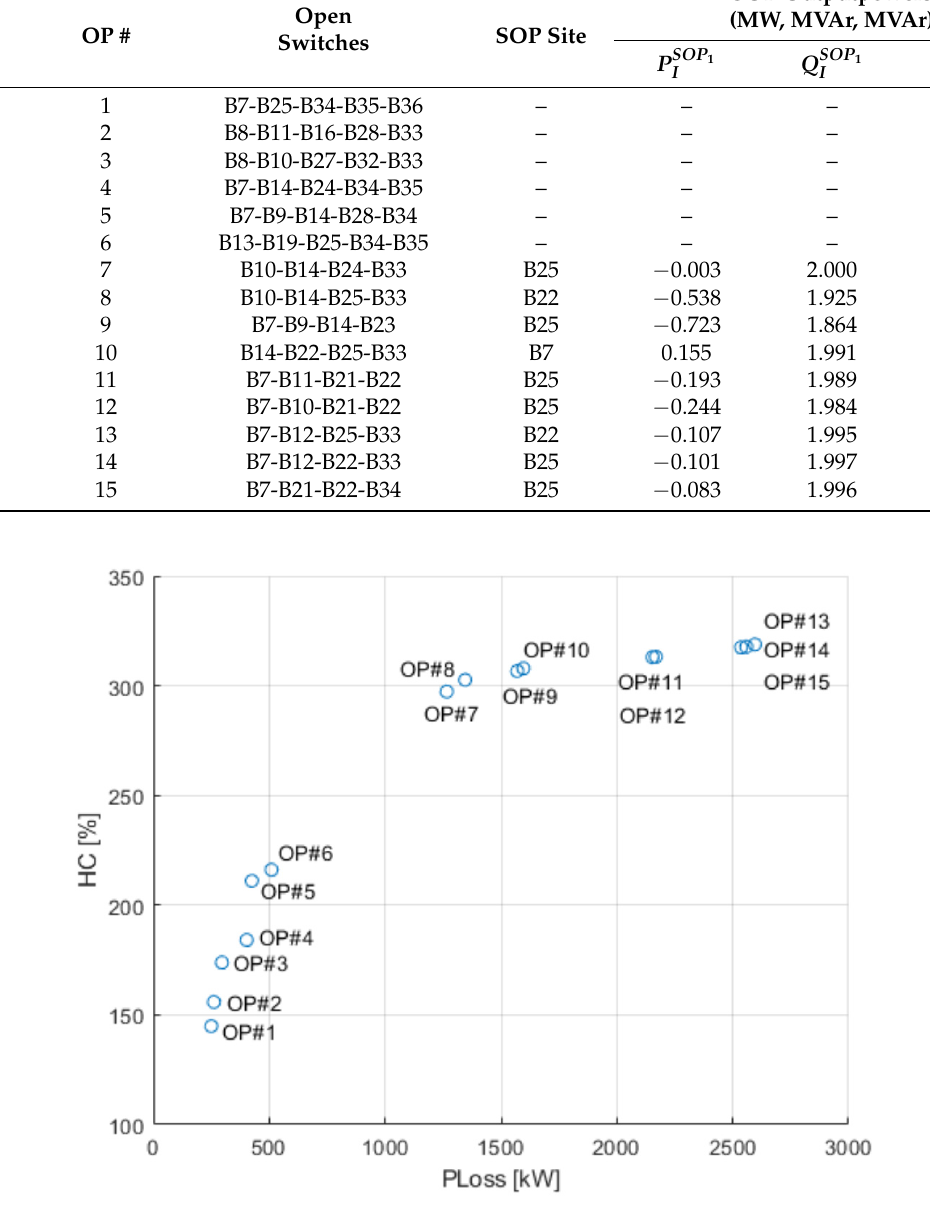
Figure 9. Pareto front of Case 2.